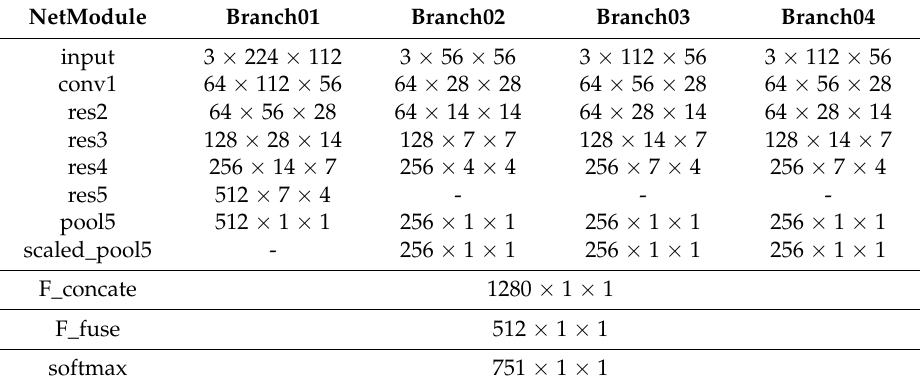
Table 1. The architecture of our four-branch network and its feature map size (Market-1501).